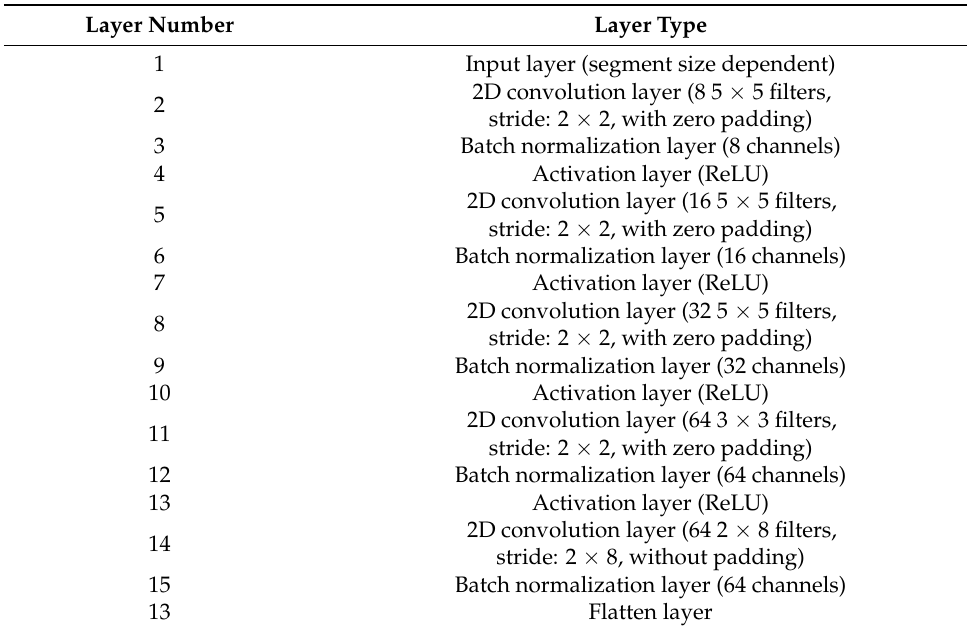
Table 5. CNN4 network structure.